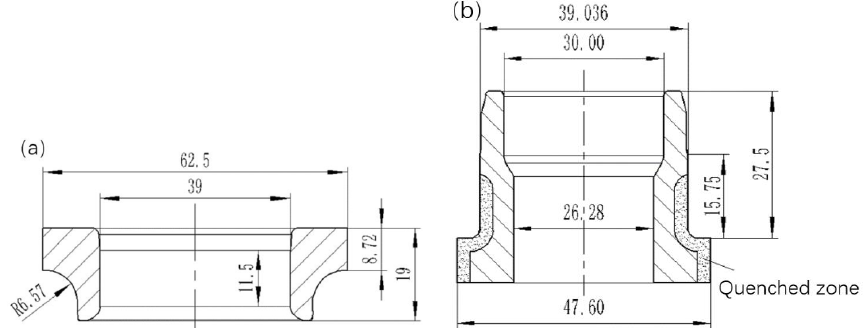
Figure 3. Key parts. ( a ) Inner ring. ( b ) Inner